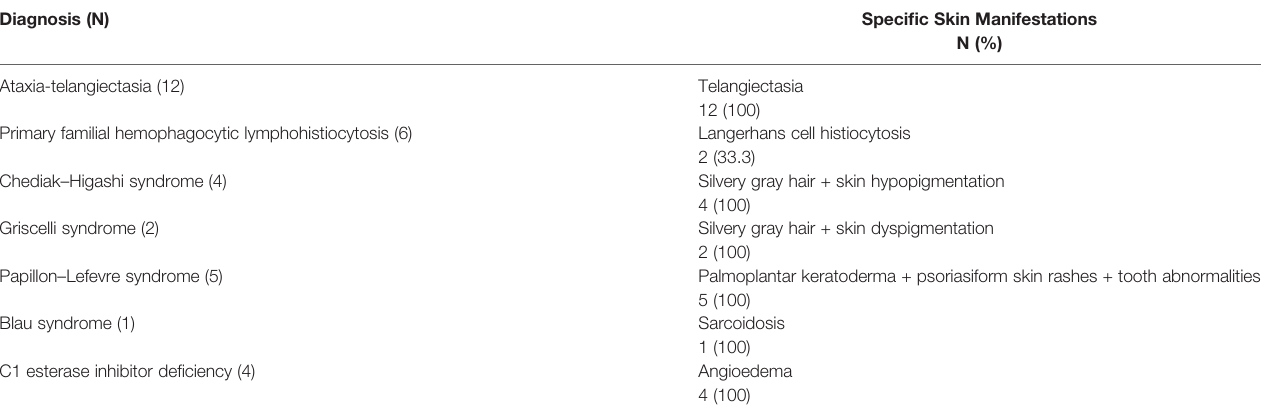
TABLE 5 | Speci fi c skin manifestations among 27 children with IEI registered in the